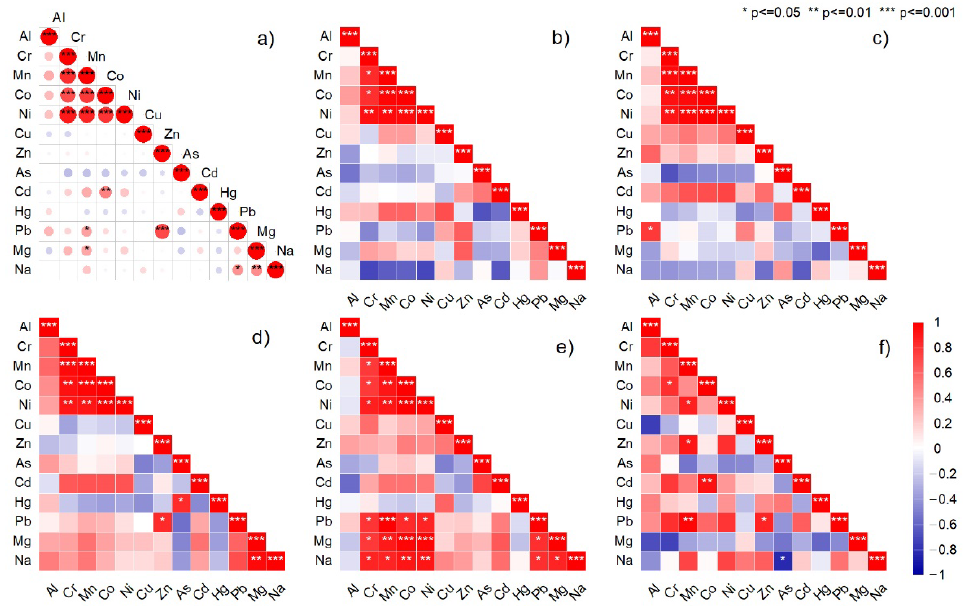
Figure 4. Correlation coefficient matrix of heavy metals concentration (mg/kg) in plant essential oil products; ( a ) All essential oil; ( b ) Thymus vulgaris L., ( c ) Lavandula augustifolia Mill., ( d ) Mentha × pipperita L., ( e ) Pinus sylvestris L., and ( f ) Juniperus communis L.